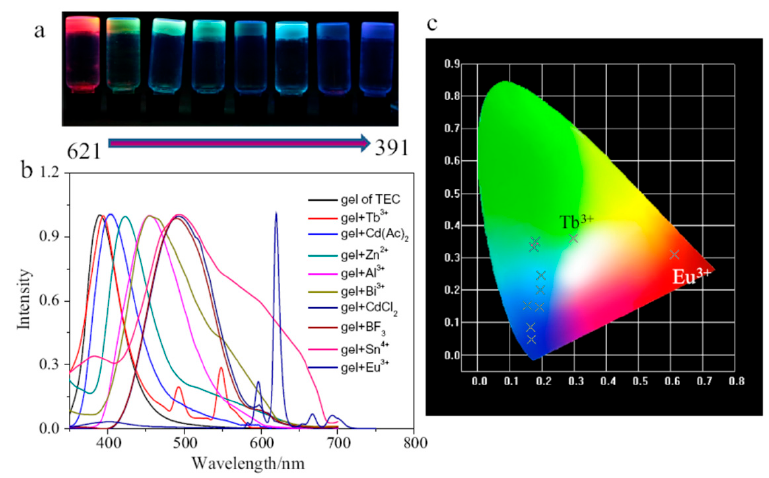
Figure 29. ( a ) The photos of 37 /ion hybrid gels in dark (irradiated at 365 nm), added ions from left to right: Eu(NO 3 ) 3 , SnCl 4 , BF 3 .OMe 2 , CdCl 2 , Al(NO) 3 , Tb(NO) 3 , Zn(NO) 3 , Cd(AcO) 2 ; ( b ) normalized fluorescence spectra of these hybrid gels; ( c ) CIE chromaticity diagram of the hybrid gels. Reprinted with permission from Elsevier [63].